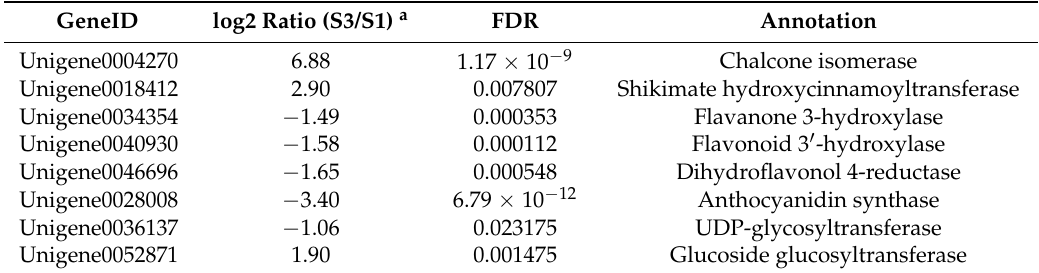
Table 1. Putative anthocyanin structural genes identified from differentially expressed genes.